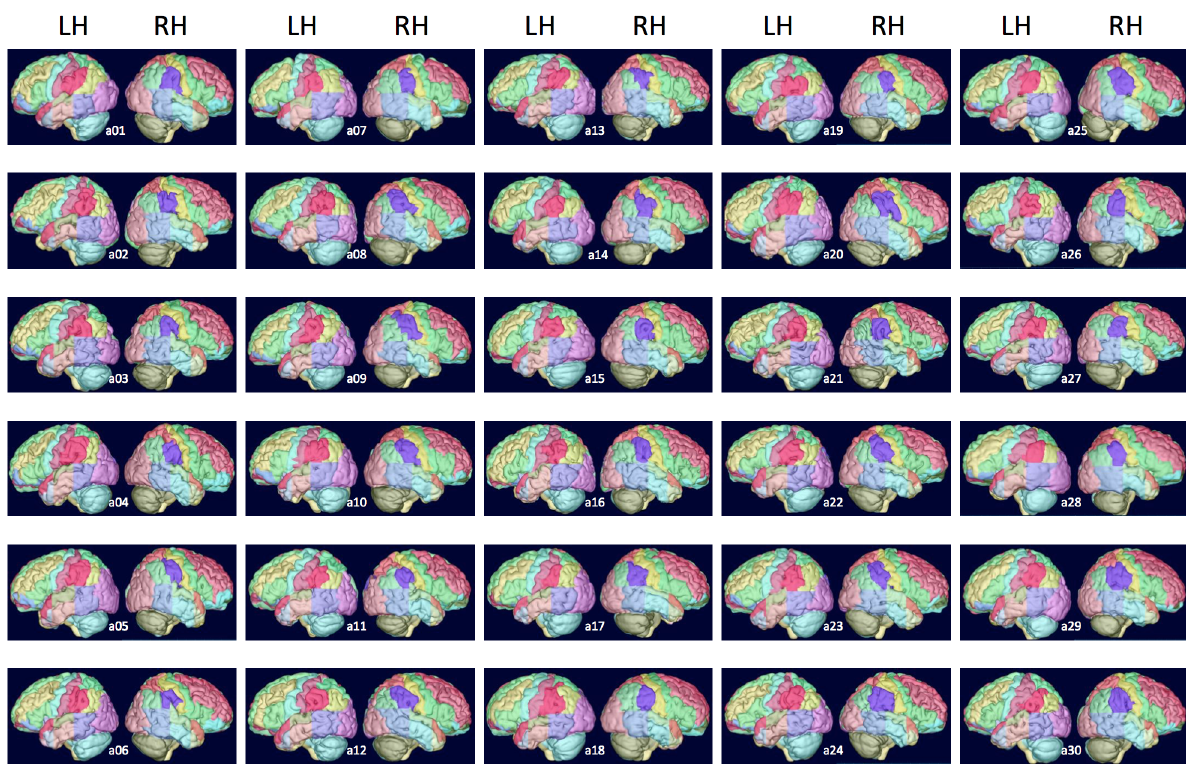
Fig 2. Lateral surfacerendering of all sixty hemispheres. Comparewith morphologicalcharacteristics per hemisphere in Tables 2 and 3.